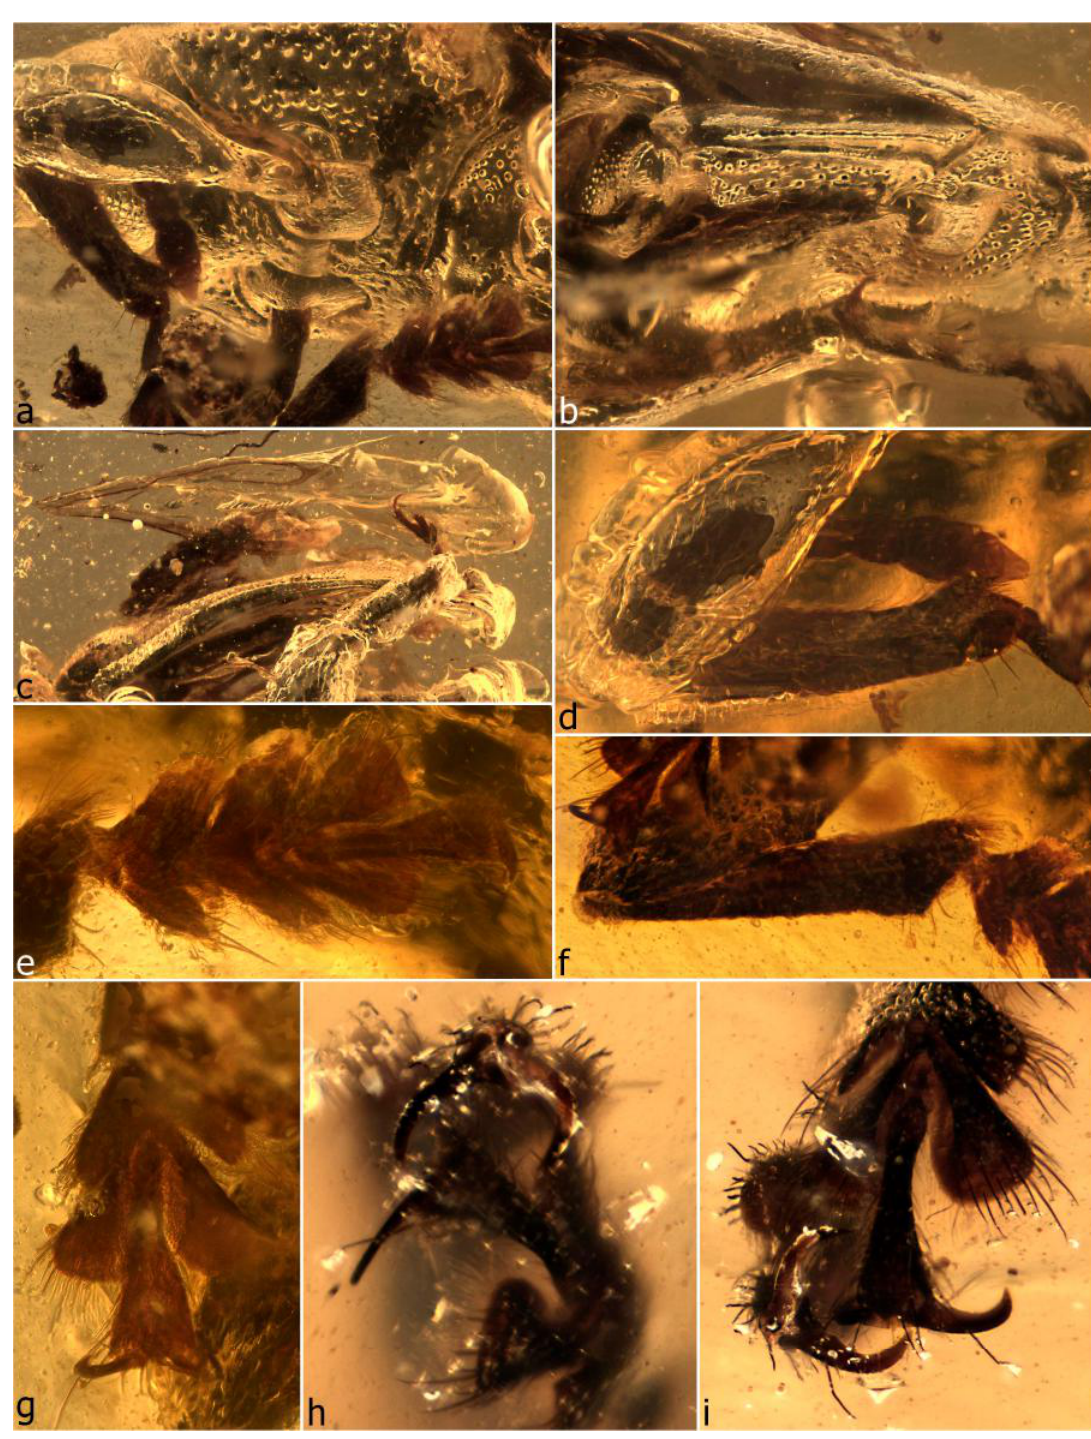
Figure 36. Petalotarsus oxycorynoides sp. n., holotype. Prothorax, ventrolateral ( a ); thorax, ventrolateral ( b ); edge of elytra, left hindleg and probable wing ( c ); left foreleg ( d ); right protarsus, dorsal ( e ); protibia ( f ); metatarsus, dorsal ( g ); right meso- and metatarsal claws ( h,i ).